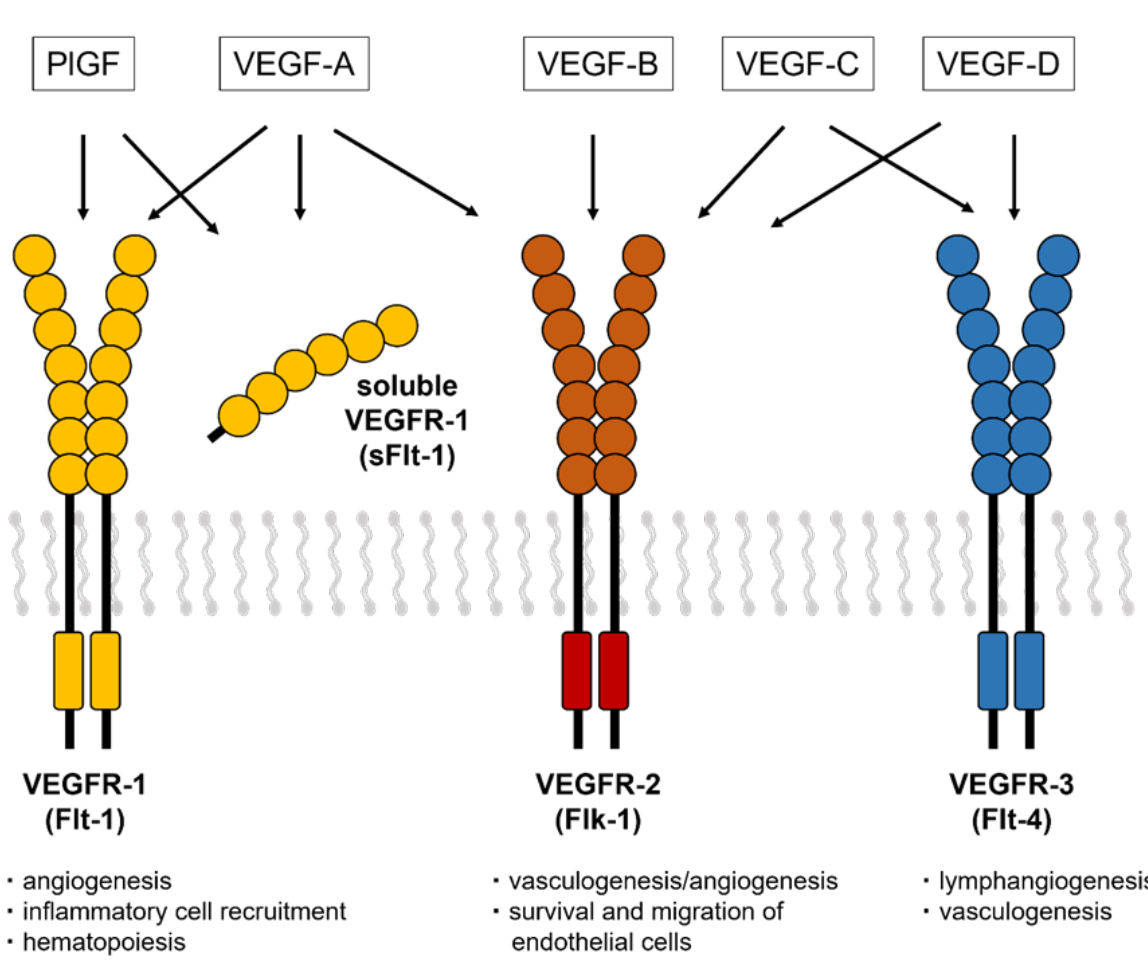
Figure 1. VEGF receptors and a soluble isoform of VEGFR-1. The VEGF isoforms have three receptors (VEGFR-1, VEGFR-2, and VEGFR-3) that contain a tyrosine–kinase domain and an extracellular region with seven Ig-like loops. The soluble isoform of Flt-1 consists of extracellular domains with motifs that bind to VEGF-A, PlGF, and heparin.